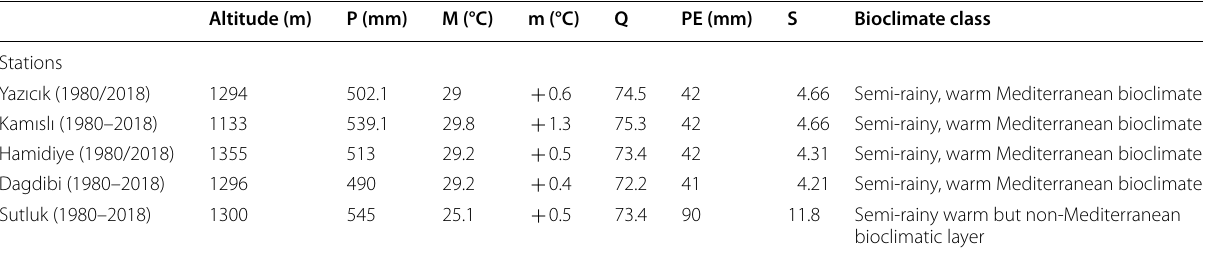
Table 10 Bioclimate dimensions calculated with long-term meteorological data indicators of the locations of the locations of the stations according to Emberger bioclimate